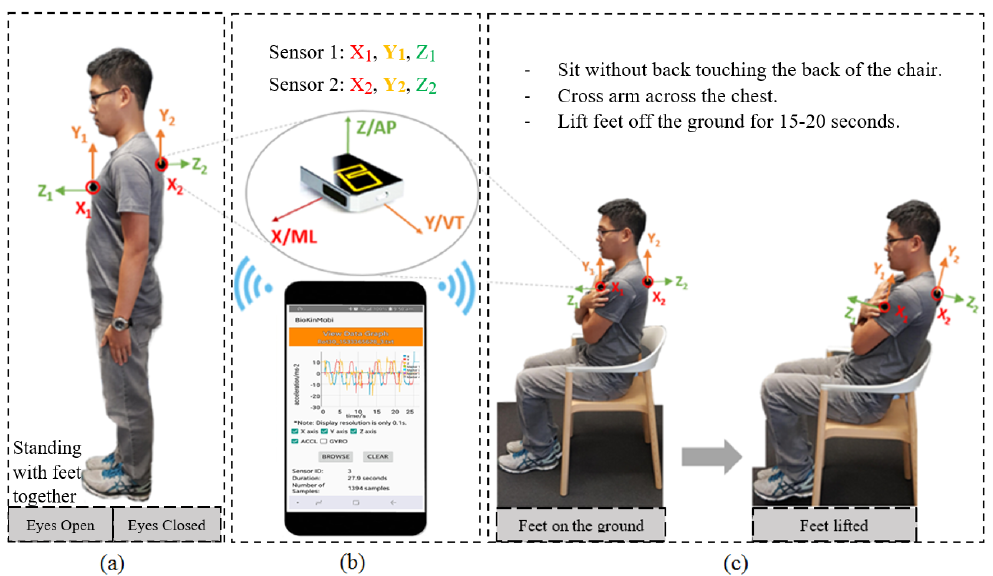
Figure 1. ( a ) Romberg test; ( b ) BioKin TM system; ( c ) Trunk